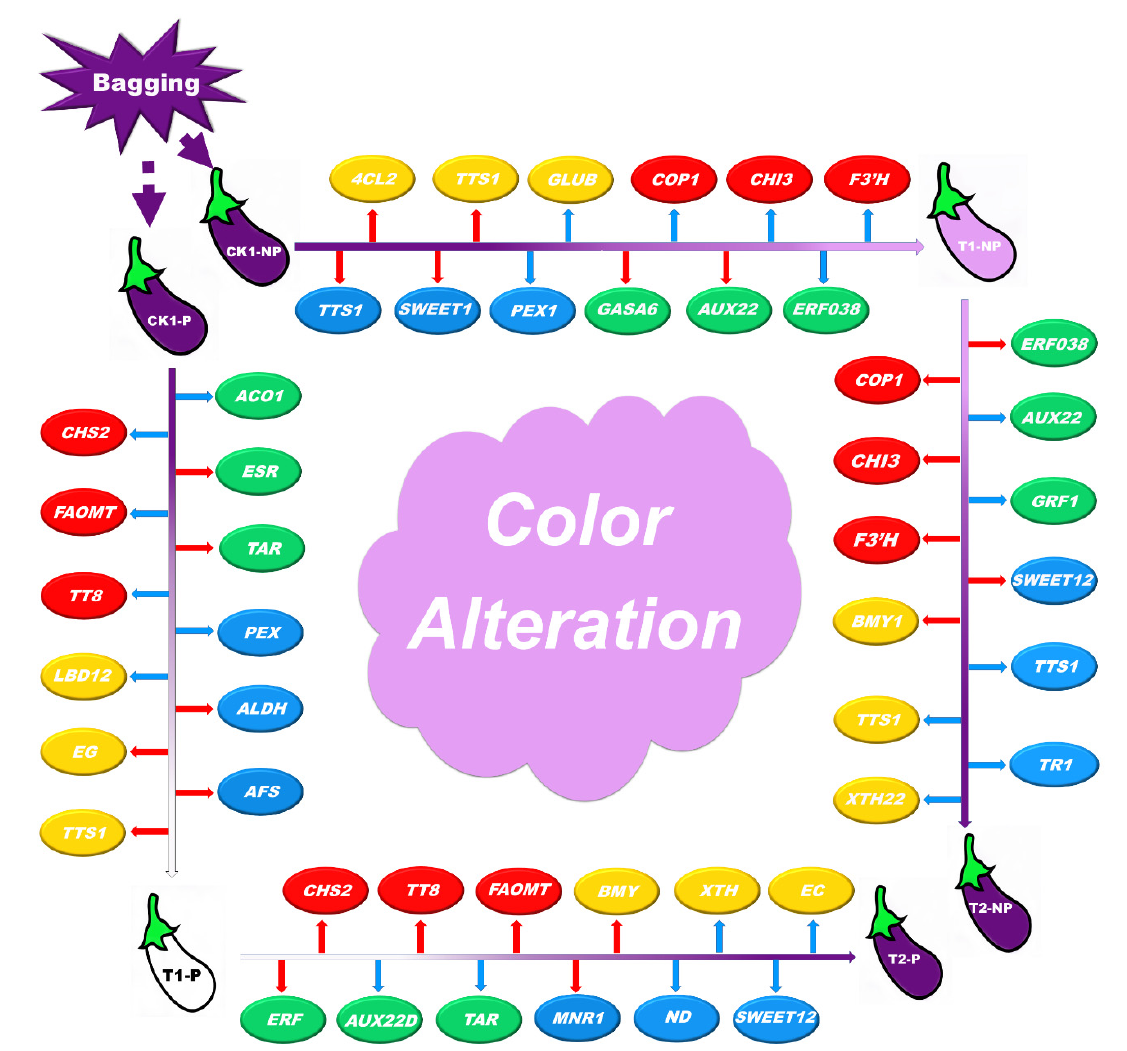
Figure 8. Model of genetic changes in response to shading and light during eggplant peel ripening. By comparing the differentially expressed genes between the two varieties of eggplant under shading and illumination, we found differences in several key genes related to color, texture, plant hormones, flavor, and aroma during eggplant peel ripening. (The blue arrow represents downregulation; the red arrow represents upregulation; the genes in the red icon are associated with eggplant color; the genes in the yellow icon are associated with eggplant texture; the genes in the green icon are associated with eggplant plant hormones; the genes in the blue icon are associated with eggplant flavor and aroma).